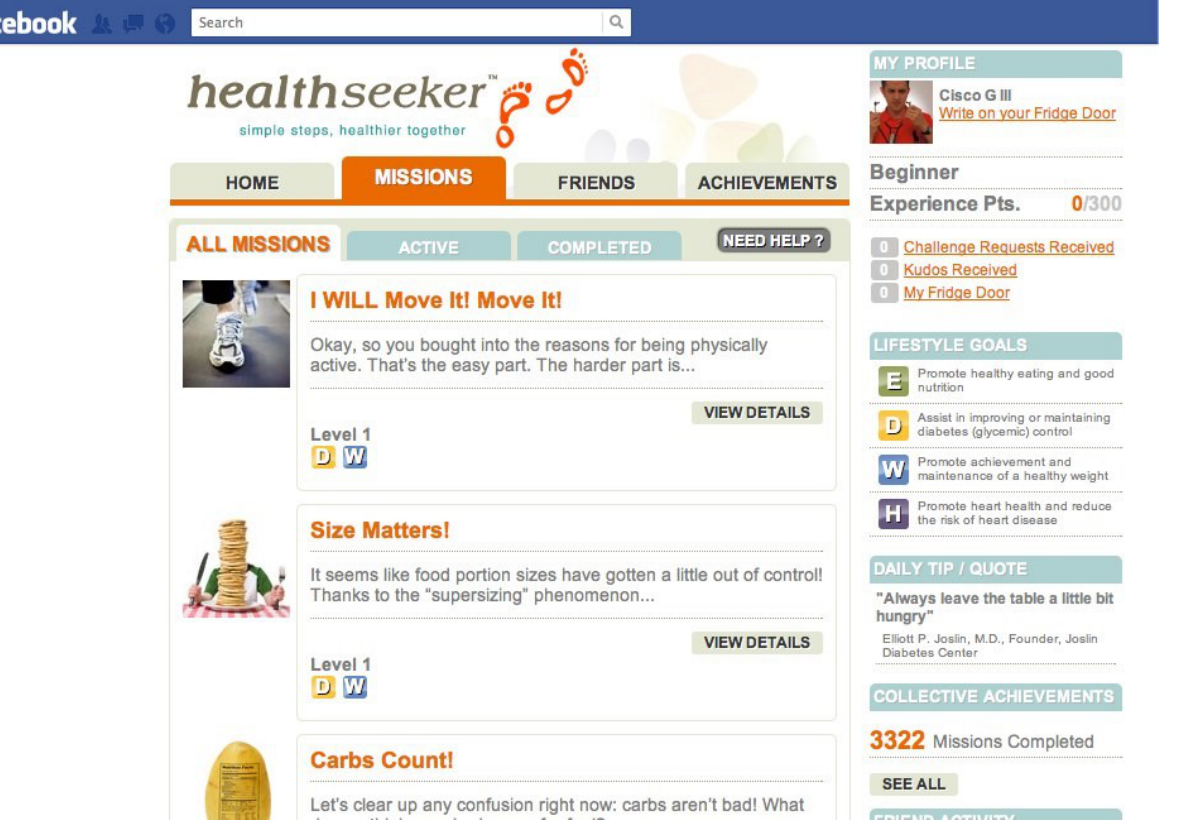
Figure 2. The HealthSeeker Diabetes Education App on